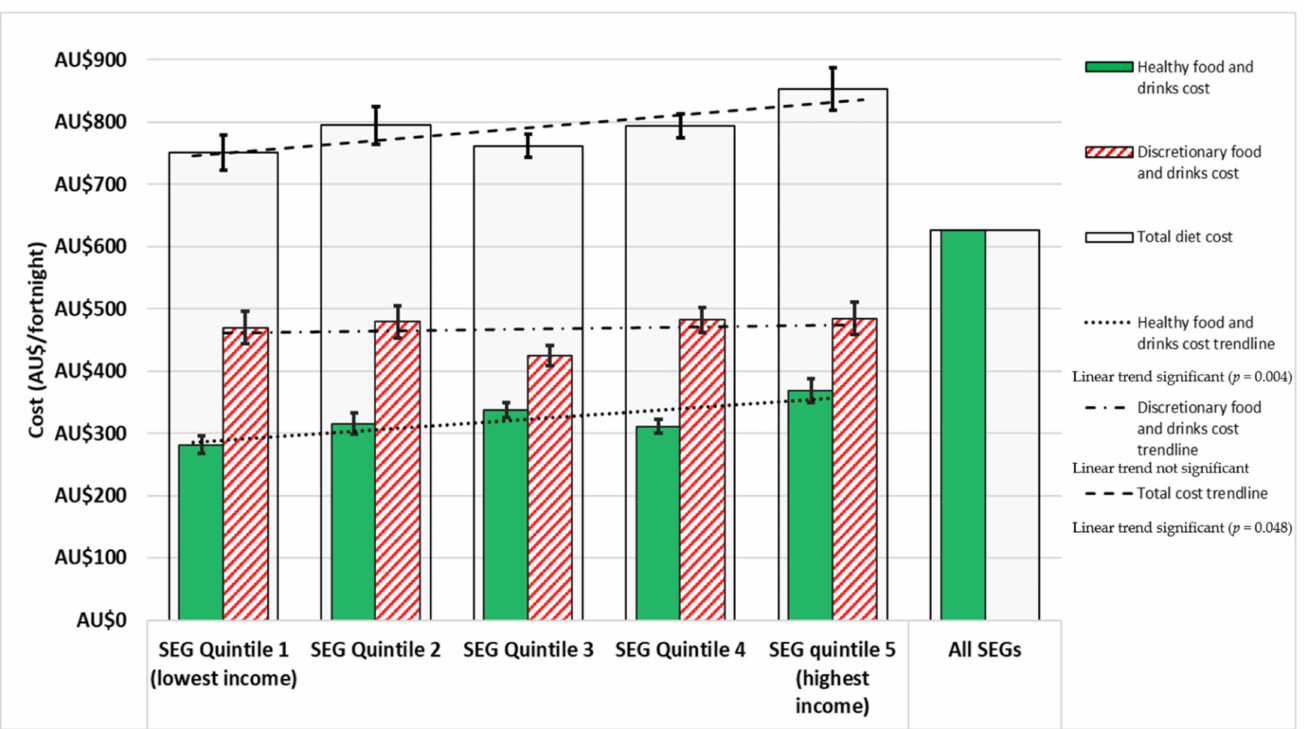
Figure 1. Cost of the habitual diet per fortnight for different SEGs, and cost of the recommended diet per fortnight, for a reference household (two adults, two children), including total diet cost, healthy and discretionary food and drink component costs. Error bars denote standard